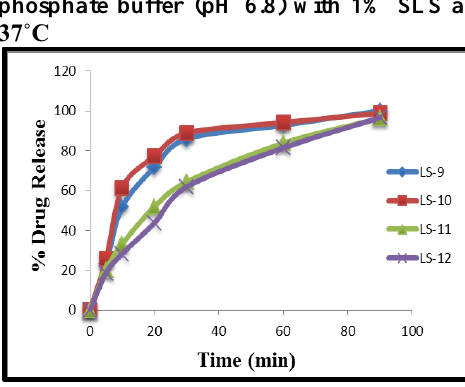
Figure 17. Dissolution profiles of clopidogrel from liquisolid compacts (LS 9 – 12) in